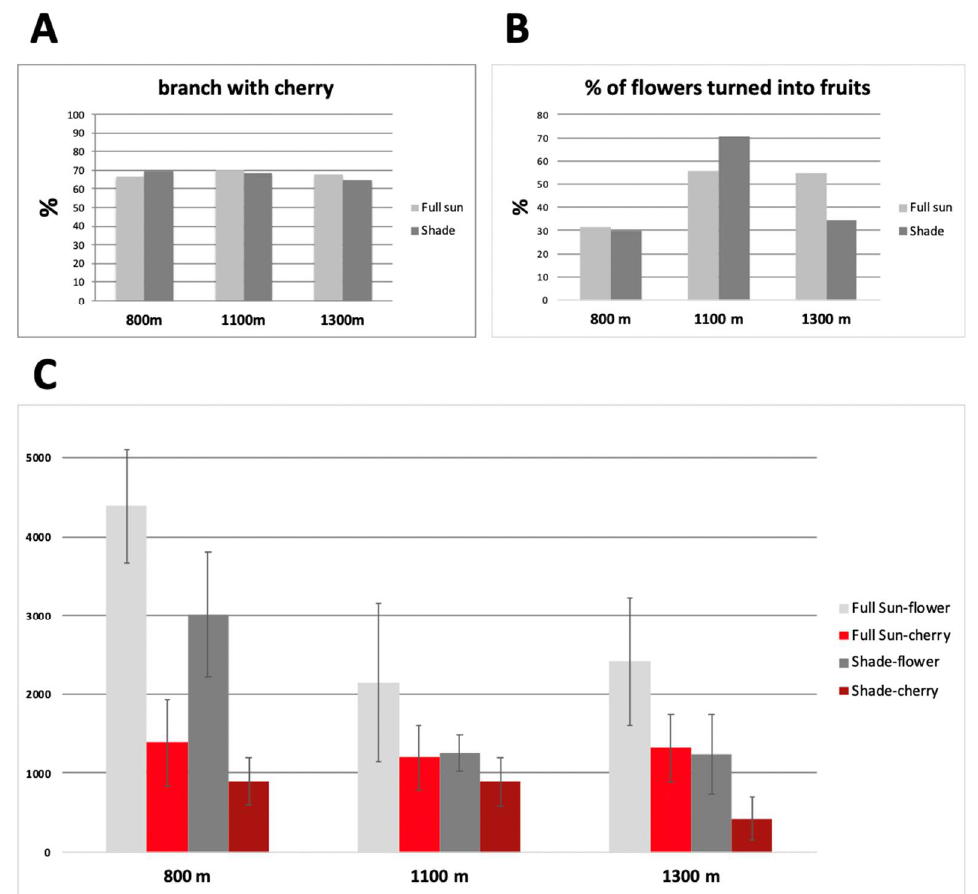
Figure 3. Flowering and productivity measurements of Marsellesa cv. cultivated in full sun and under shade at three elevations. ( A ) Comparison, expressed as a percentage, of the number of fruit-bearing branches in the two growing conditions at the three elevations. ( B ) Percentage of flowers converted to fruit. ( C ) Number of flowers and fruits counted from 25 trees for each condition and elevation.